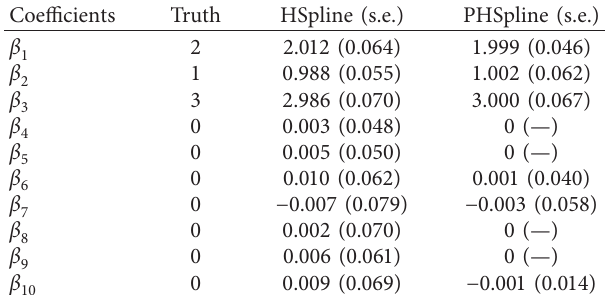
Table 7: Simulation result of Example 5.